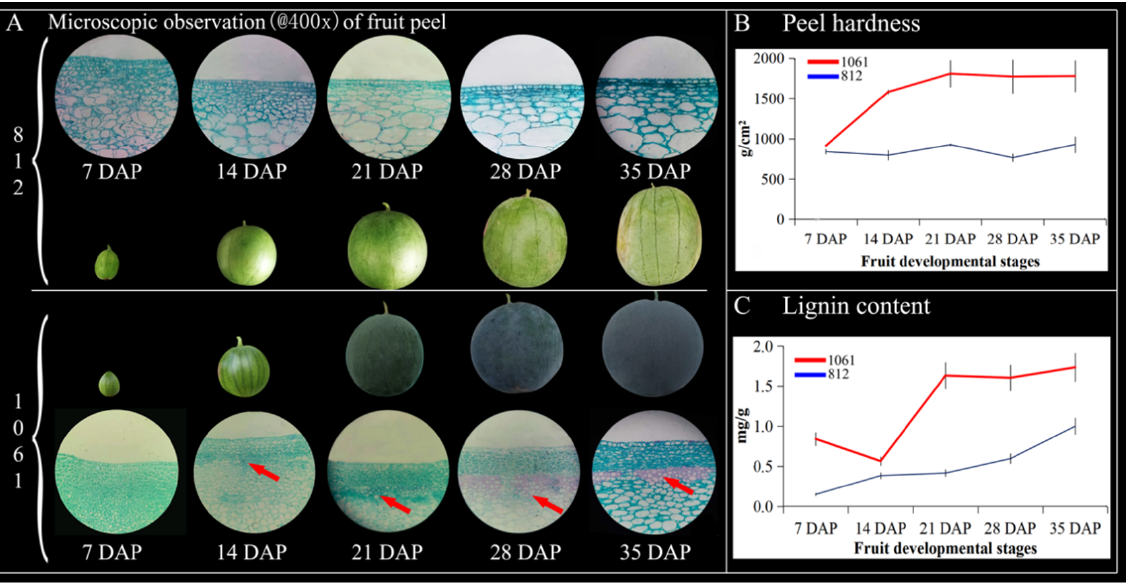
Figure 10. Watermelon peel microstructure ( A ); red bold arrows indicate the formation of the stone cell structure. Peel hardness of watermelon materials ( B ); and lignin contents of watermelon peel materials ( C ); red and blue lines represent the differences in the values of the means ± SD bars, and bold red arrows indicated the stone cell structure formation in the 1061 and 812 materials, respec- tively.